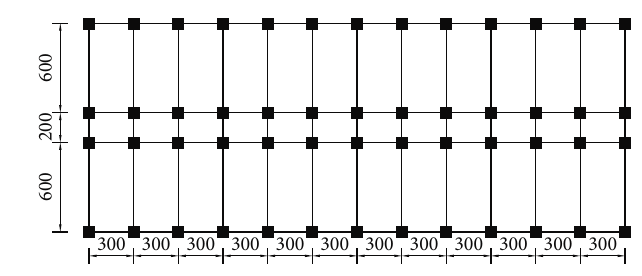
Figure 4: The standard layout of the